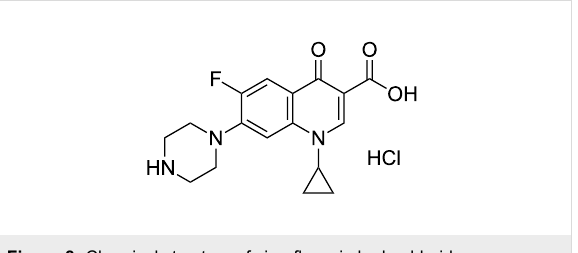
Figure 8: Chemical structure of ciprofloxacin